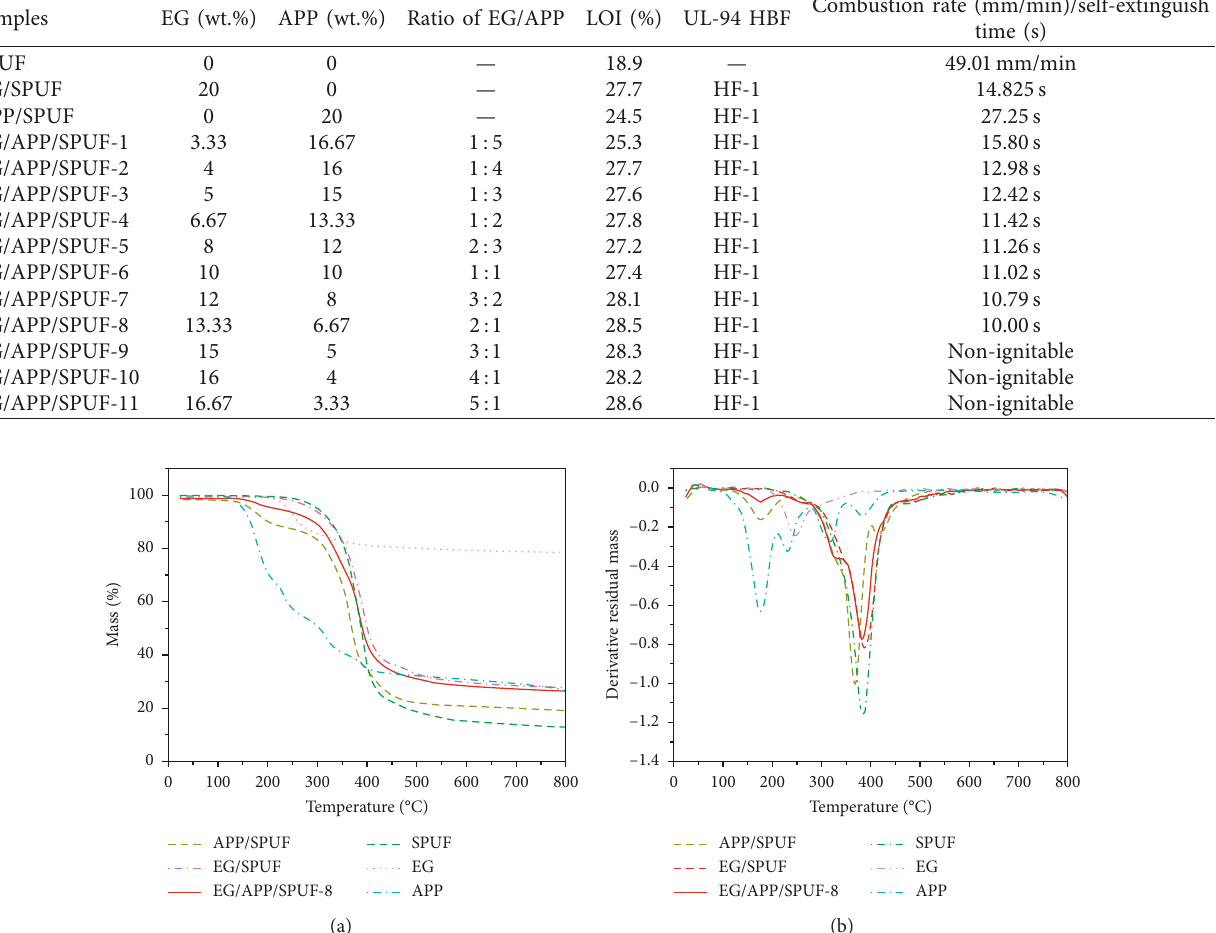
Table 2: Flammability of SPUF containing various concentrations of flame retardants.